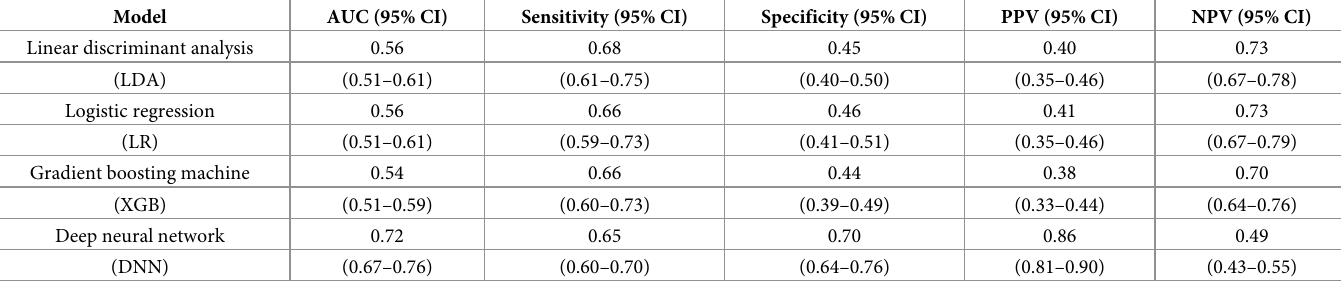
Table 1. Area under the receiver operating characteristic curves (AUROC) for each machine learning classifier on the test data set.